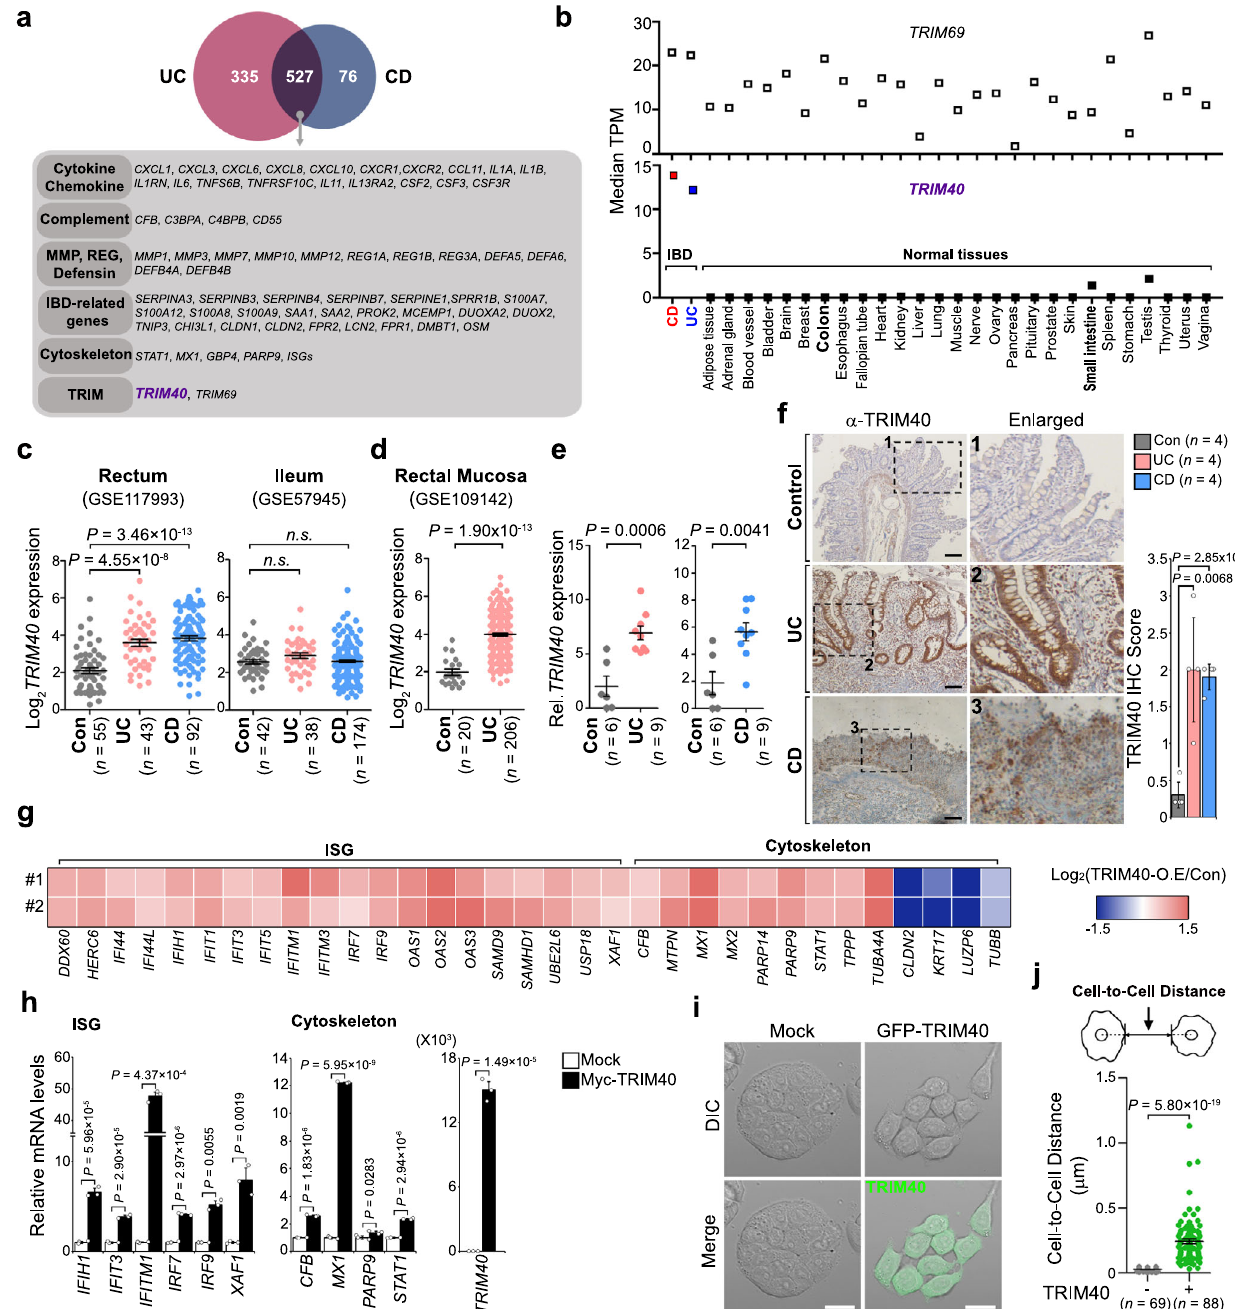
Fig. 1 | TRIM40 upregulation is associated with IBD pathogenesis through morphological and cytoskeletal alterations. a Venn diagram illustrating the overlap among differentially expressed genes from UC and CD patients, and healthy controls. b TRIM69 or TRIM40 expression in RNA-seq data from IBD (GSE117993) compared with normal tissues from the Genotype-Tissue Expression project. Bold letters; normal intestinal tissues. c , d Comparison of TRIM40 expression in the rectum and ileum ( c ) or rectal mucosa ( d ) between UC, CD, and normal samples (GSE117993, GSE57945, and GSE109142). P values are determined by unpaired two-tailed t test. ( n , numbers of patients; mean±SD). n.s.; not sig- ni fi cant. e qPCR showing TRIM40 mRNA levels in IBD compared with normal tis- sues. P valuesaredeterminedbyunpairedtwo-tailed t test.( n ,numbersofpatients; mean±SD). f IHCanalysisofTRIM40oncontrol,UC,orCDpatients.ThemeanIHC score ± SD of all samples from controls, UC, or CD was 0.3±0.17, 2.0±0.71, 1.9±0.17,respectively(×100). P valuesaredeterminedbyunpairedtwo-tailed t test. ( n =4biologically independent samples;mean±SD).Enlarged views of the regions